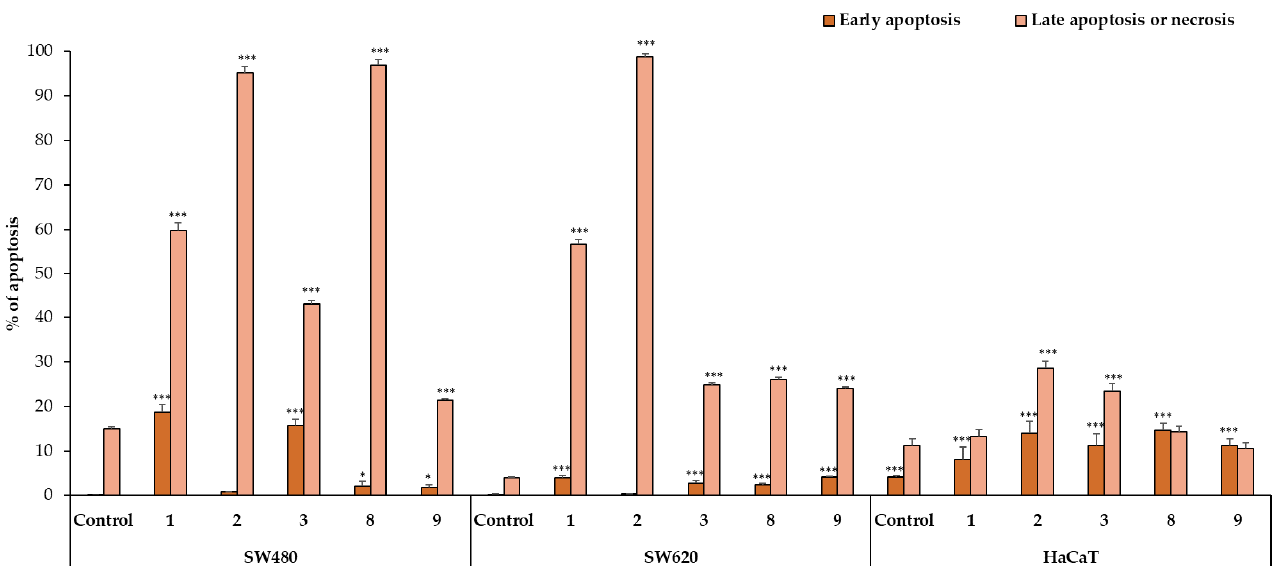
Figure 3. The effect of compounds 1 – 3 , 8 , and 9 on early and late apoptosis in PC3 and K-562 cells. Cells were incubated for 72 h with the tested compounds used in their IC 50 concentrations, then cells were harvested, stained with Annexin V-FITC and PI, and analyzed using flow cytometry. Data are expressed as % of cells in the early stage of apoptosis, and as % of cells in the late stage of apoptosis. Data are expressed as the means ± SD. *** p ≤ 0.001, * p ≤ 0.05, as compared to the control.